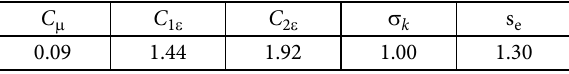
4860 4890 4870 3870 3890 3880 4500 4580 4550 4190 4180